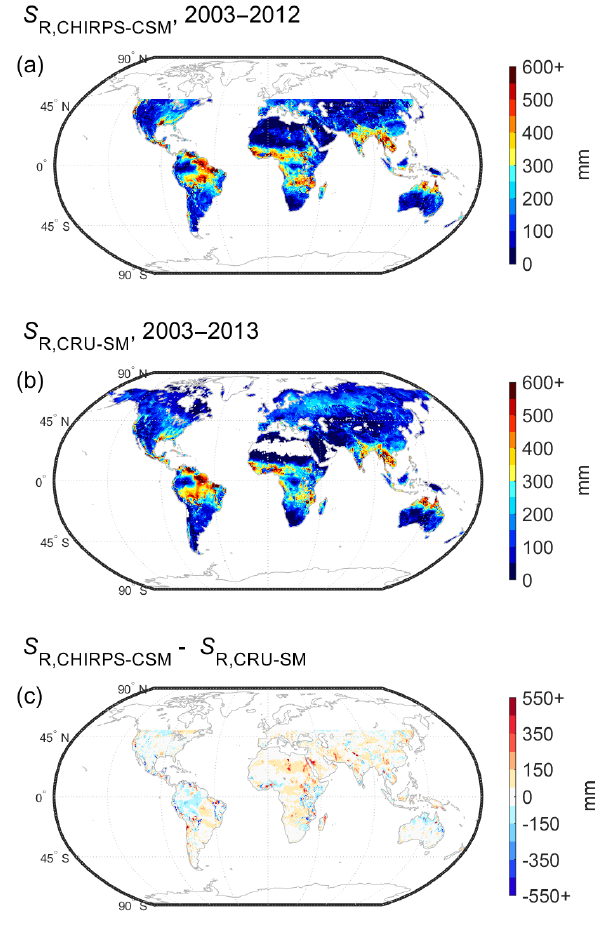
Figure 3. Root zone storage capacity estimates of (a) S R,CHIRPS-CSM (based on P CHIRPS and E CSM ), (b) S R,CRU-SM (based on P CRU and E SM ), and (c) the difference between S R,CHIRPS-CSM and S R,CRU-SM . Values below 0.5% of the maximum in (a) and (b) are displayed as white.